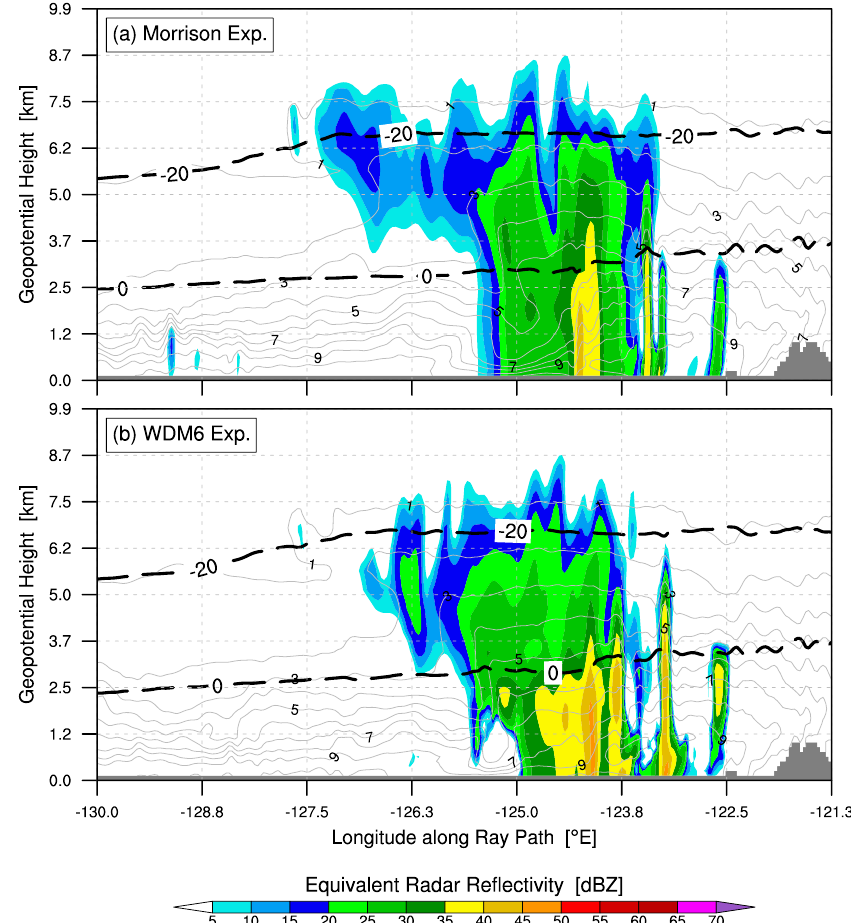
Figure 5. Equivalent radar reflectivity (shaded, dBZ) and specific humidity (contours, g kg − 1 ) over a cross section through the innermost domain and valid at 18:00 UTC 06 February 2015 for the ( a ) Morrison and ( b ) WDM6 experiment. This cross section follows the longest (and northernmost) ray path indicated in Figure 4. The 0 and − 20 ◦ C isotherms of temperature are indicated by the thick dashed black lines and the topography is indicated by gray